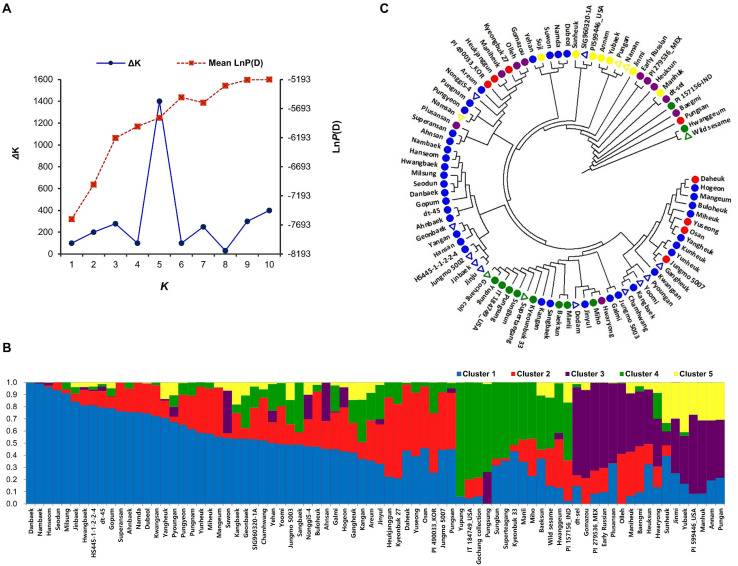
Population structure and genetic diversity of sesame accessions inferred using 8,883 single nucleotide polymorphisms. (A) Delta K-values calculated by Evanno’s method. (B) Classification of sesame accessions using STRUCTURE v. 2.3.4 software. (C) Neighbor-joining phylogenetic tree of sesame accessions. Triangles indicate resistant sesame accessions.